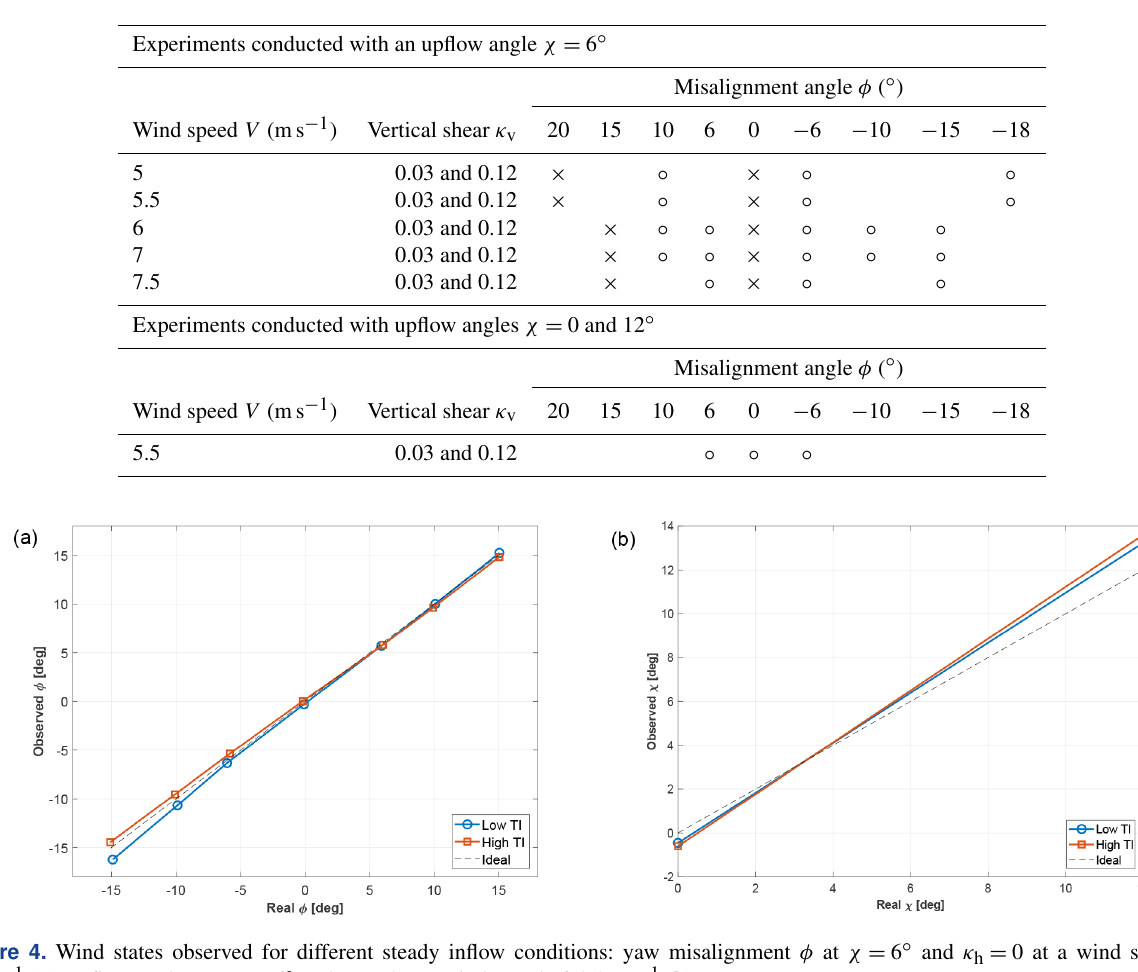
Figure 4. Wind states observed for different steady inflow conditions: yaw misalignment φ at χ = 6 ◦ and κ h = 0 at a wind speed of 7ms − 1 ( a ), upflow angle χ at φ = 6 ◦ and κ h = 0 at a wind speed of 5.5ms − 1 ( b